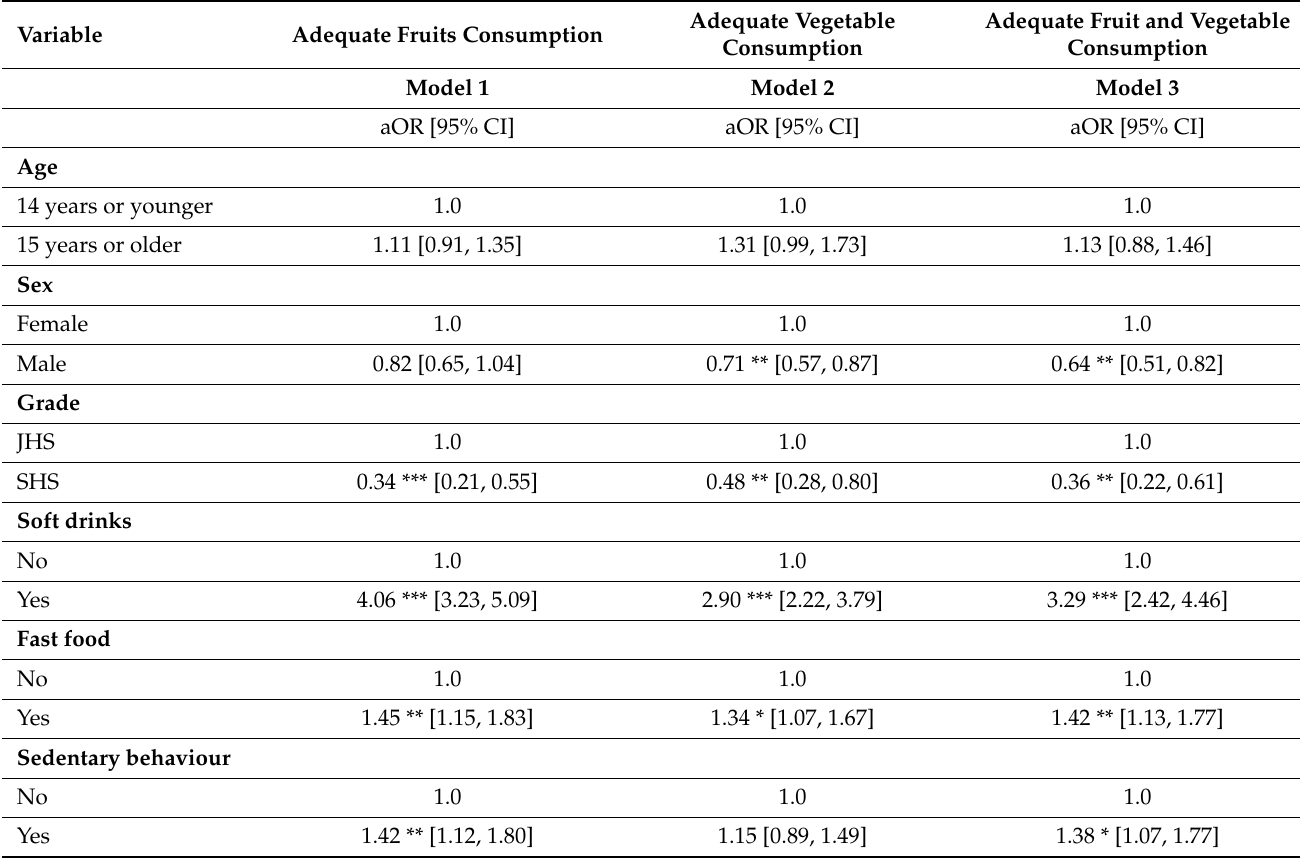
Table 2. Multivariable regression analysis on predictors of adequate fruit and vegetable consumption among in-school adolescents in